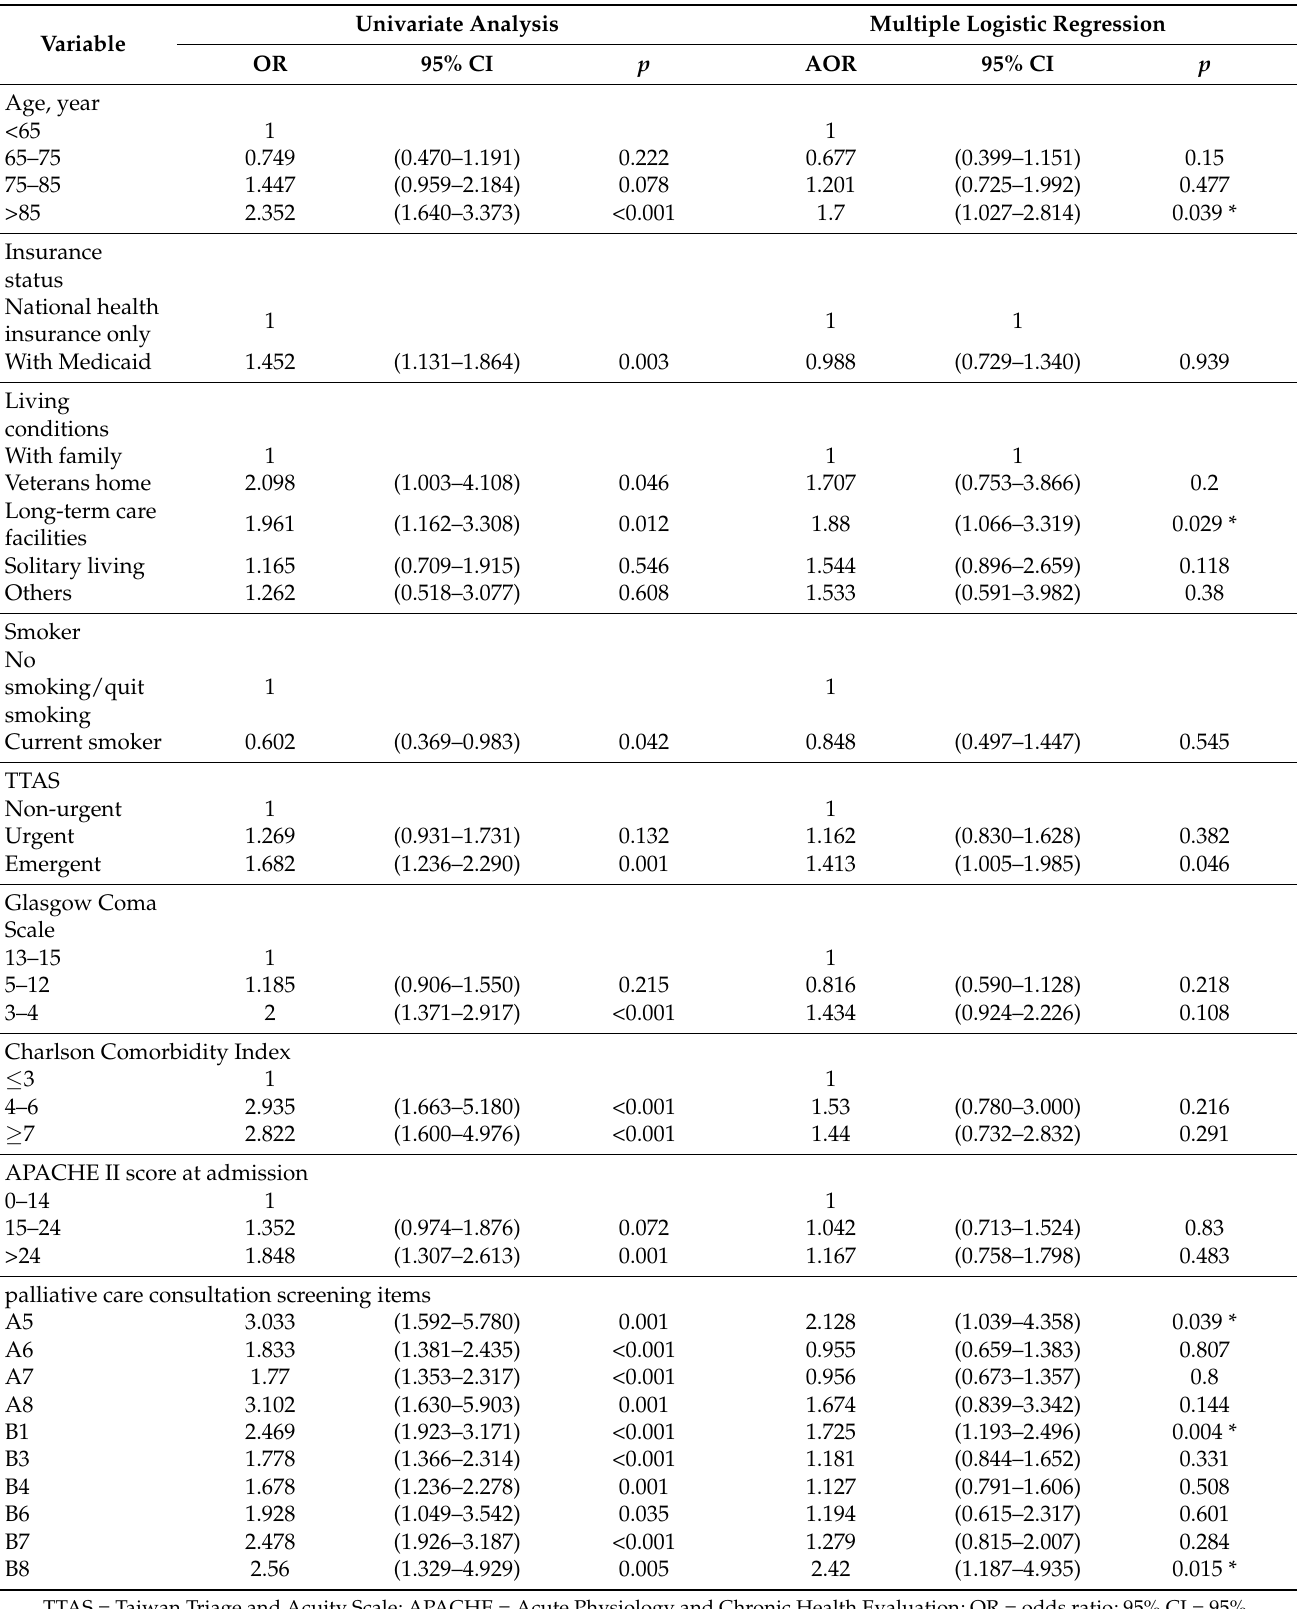
Table 3. Univariate and multiple logistic regression analyses of clinical characteristics between early DNR and late DNR patients. Univariate Variable